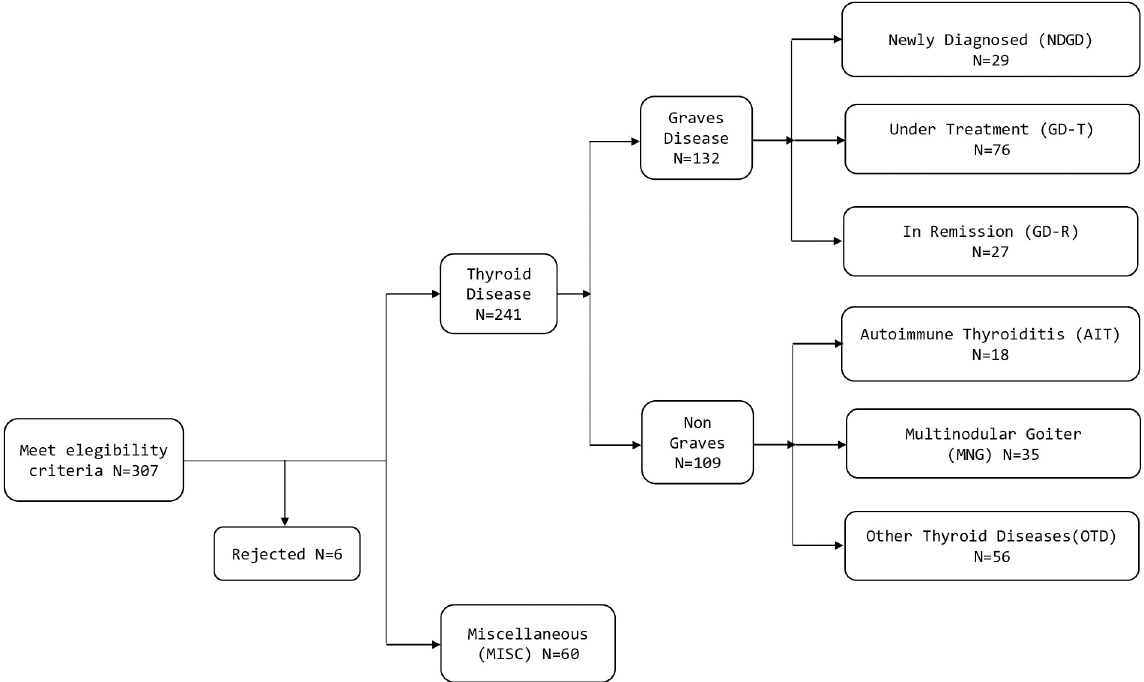
Fig 1. Patient distribution in different clinical groups according to the final